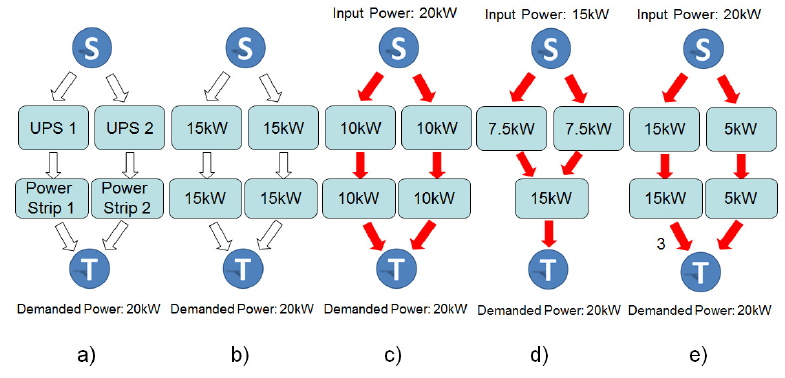
Figure 6. ( a ) Power system example; ( b ) maximum power capacity; ( c ) successful energy flow; ( d ) failed energy flow; and ( e ) example showing weights on the